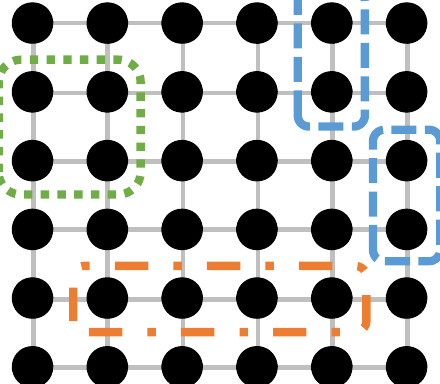
Fig. 4 Illustration of 6x6 2-D lattice with nearest-neighbor coupling. Here the Hamiltonian is k -local with k = 2. Colored dashed outlines show possible subsets of size s = 4, each of which is formed from two (possibly distant) pairs of connected neighbors. The total number of ways to choose such subsets from this lattice is 3540. Running the randomized analog veri fi cation protocol on all such subsets will test for errors associated with each interaction term in the Hamiltonian, as well as errors that may be caused by unwanted interaction (e.g., crosstalk) between any two pairs of sites in the